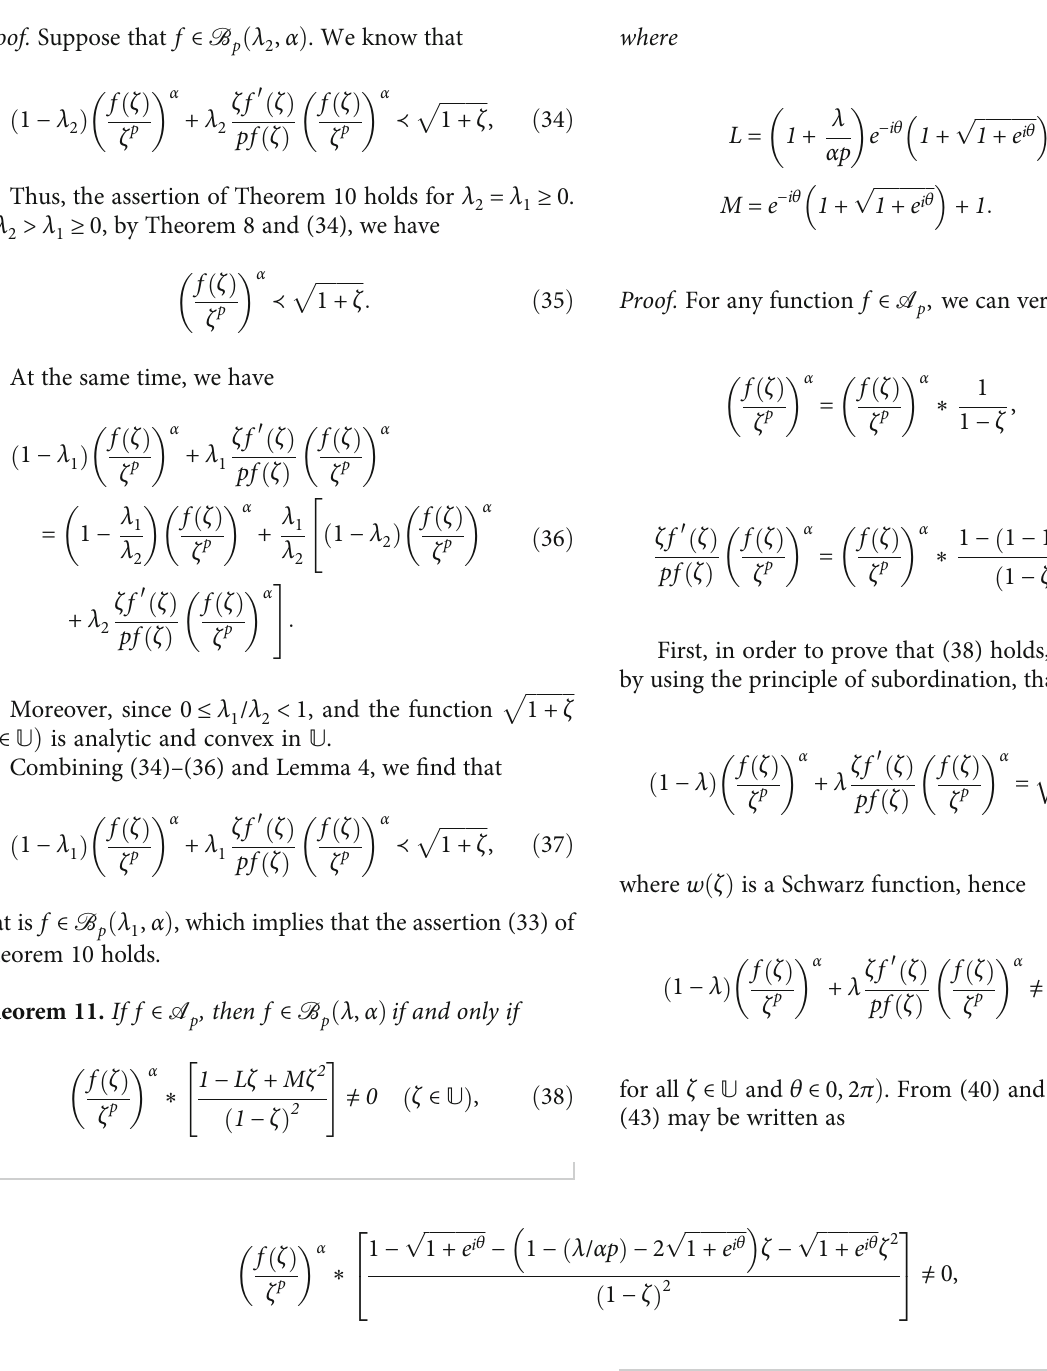
(cid:1) ffiffiffiffiffiffiffiffiffiffiffiffi ffiffiffiffiffiffiffiffiffiffiffiffi p 1 + e i θ